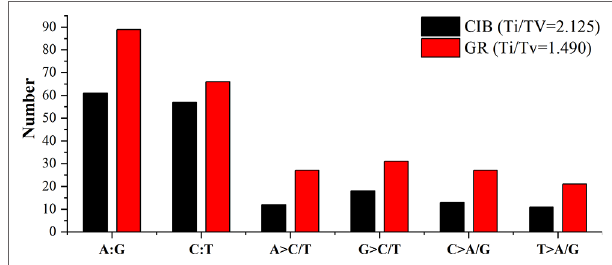
FIGURe 8 | Transitions and transversions of induced by CIB irradiation and GRs. A:G and C:T are transitions. A > C/T, G > C/T, C > A/G, and T > A/G are transversions.